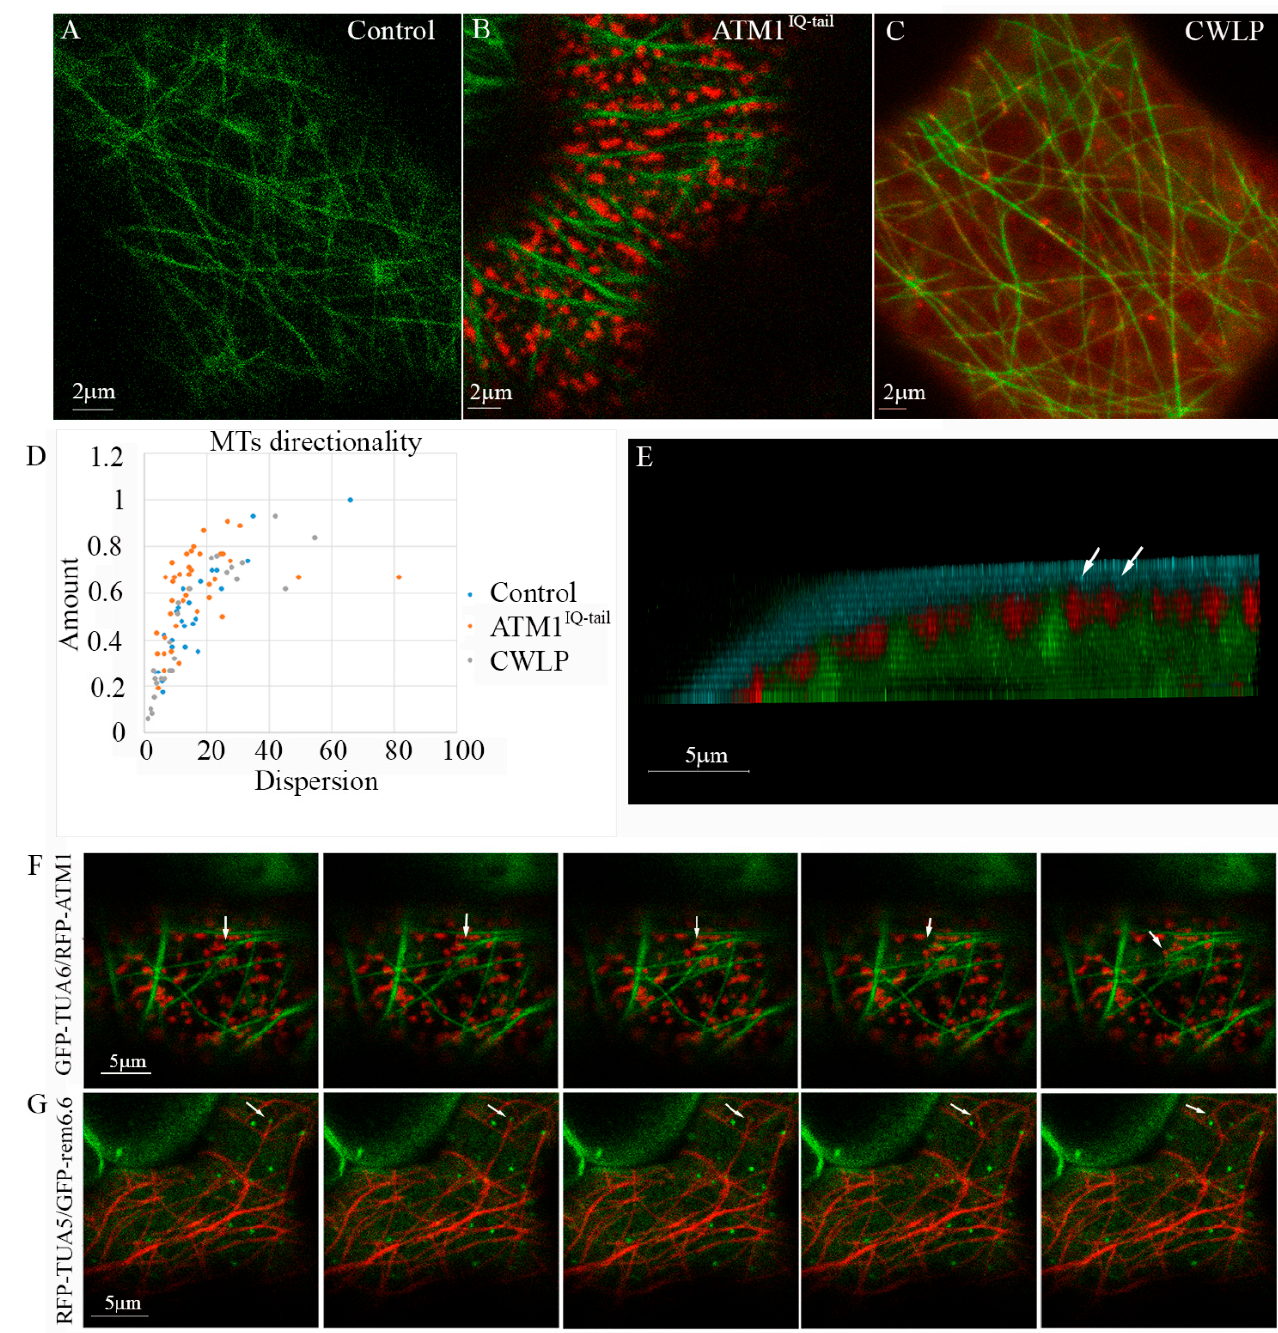
Figure 2. Coordinated organization of ATM1 IQ-tail and cortical MTs. 35S-GFP-TUA6 expressing N. benthamiana plants ( A ) were infiltrated with 35S-mCherry-ATM1 IQ-tail ( B ) or CWPL-RFP ( C ). Confocal microscopy was performed 48 h after Agrobacterium infiltration, for imaging the abaxial side of epidermal cells. ( D ) MTs orientations were determined by the directionality plugin of ImageJ in 25–40 cells. Amount refers to the fraction of MTs and dispersion to the distribution of different angles. ( E ) Z-axis view of a N. benthamiana epidermal cell labeled with FM4-64 (blue), ATM1 IQ-tail (red-arrows), MTs (green). ( F ) Five frames (2 sec intervals) from Movie S2 showing a shift (arrows) in MT orientation after a collision with ATM1 IQ-tail cluster in N. benthamiana epidermal cells expressing GFP-TUA6 and mCherry ATM1 IQ-tail . ( G ) Five frames (2 sec intervals) corresponding to Movie S3 showing a shift (arrows) of orientation of mCherry-TUA5 labeled MT after a collision with GFP-remorin 6.6 labeled structure in A. thaliana epidermal cell.